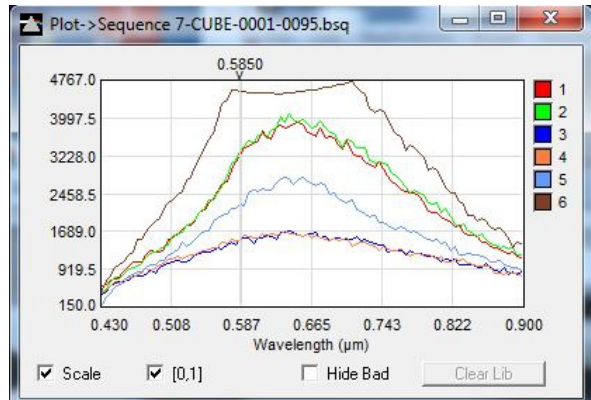
Figure 8. Spectral plot of samples taken from different fragments. The number on spectral plot corresponds to the number written next to